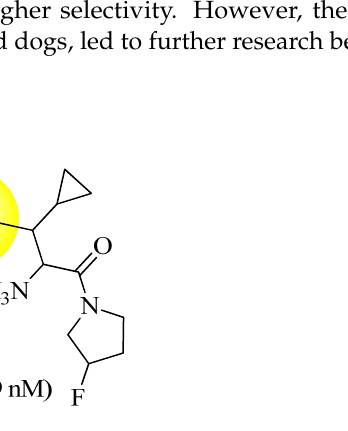
Figure 16. 1,2,4-Oxadiazole derivative as a potent DPP-IV inhibitor.